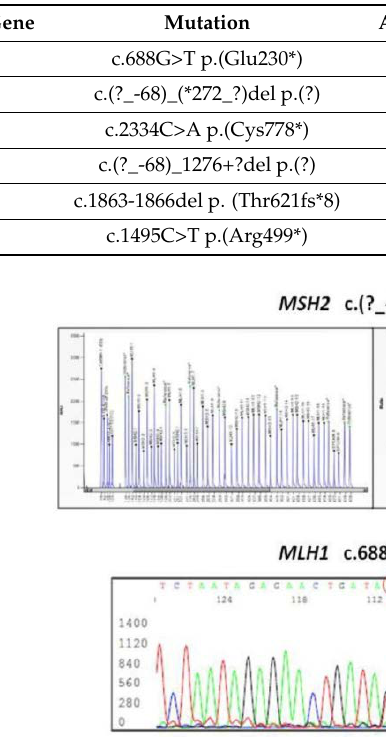
Table 1. Molecular and pathological features of gastric cancer and adenoma in Lynch syndrome and FAP.